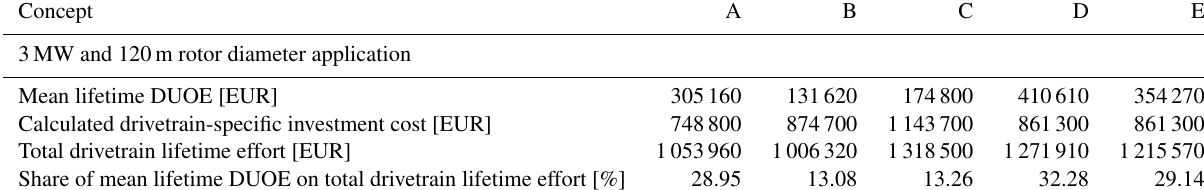
Table 5. Concept-specific DUOEs’ lifetime impact on the total drivetrain lifetime effort for the 3MW 120m rotor application.